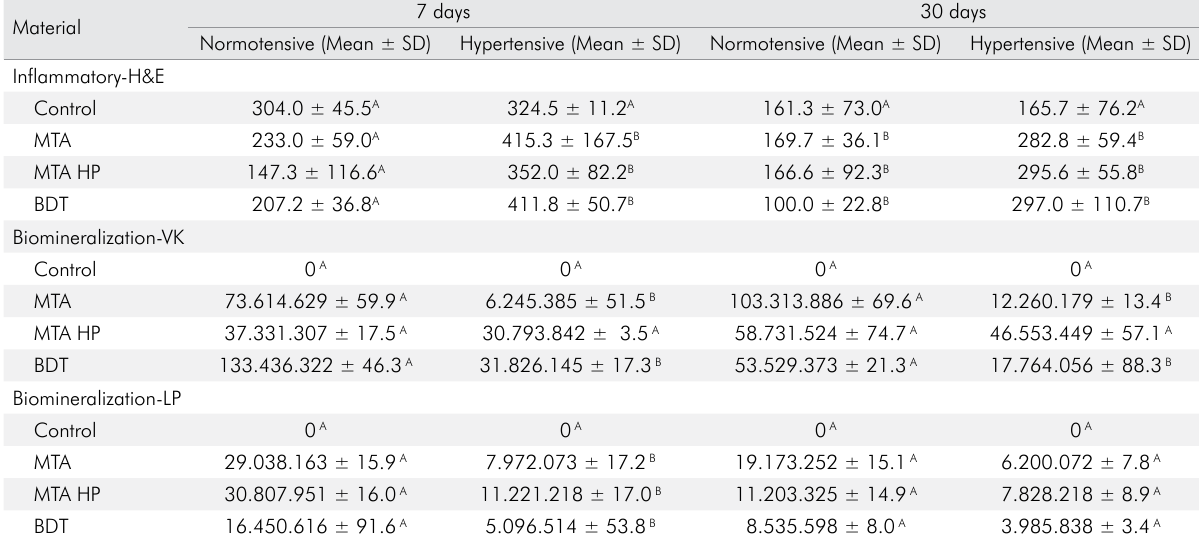
Table 2. Means of inflammatory response and biomineralization area under hypertensive and normotensive conditions in the control group, Mineral Trioxide Aggregate (MTA), High-plasticity MTA (MTA HP) and Biodentine ® (BDT) at 7 and 30